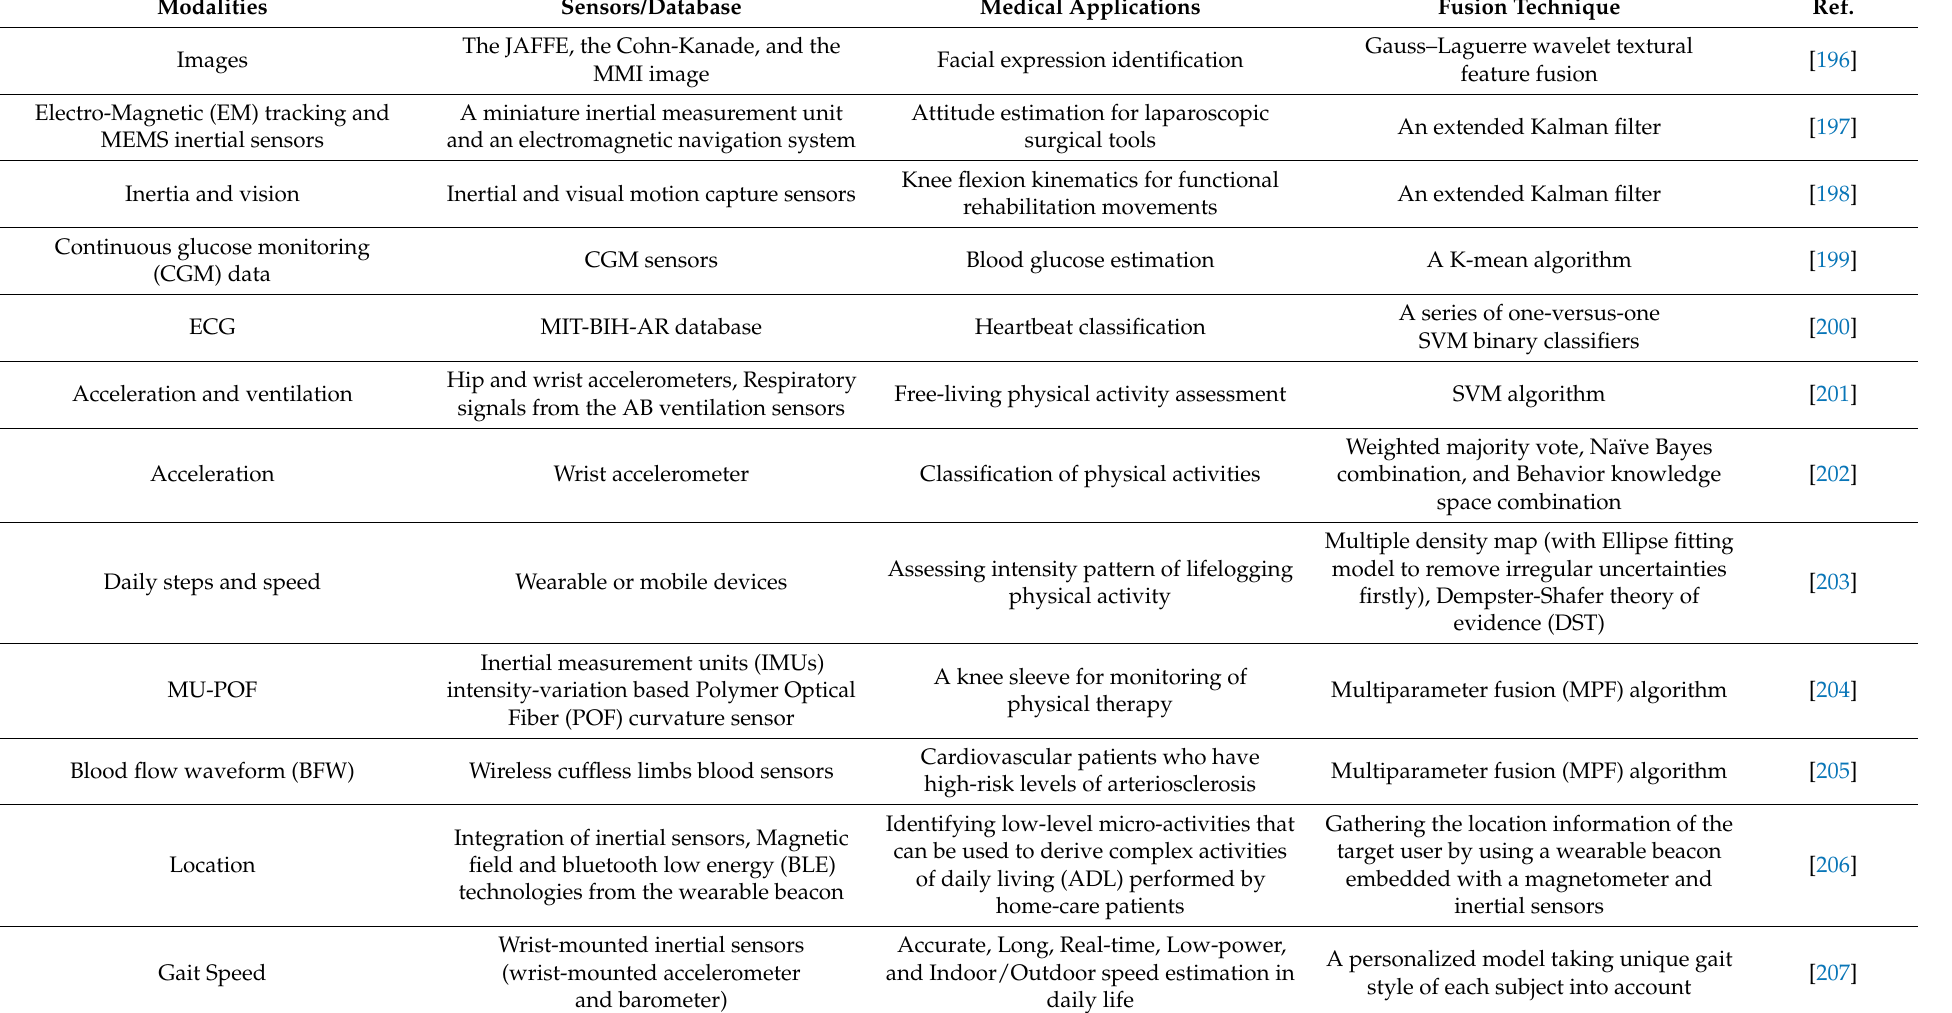
Table 6. Information fusion of different information